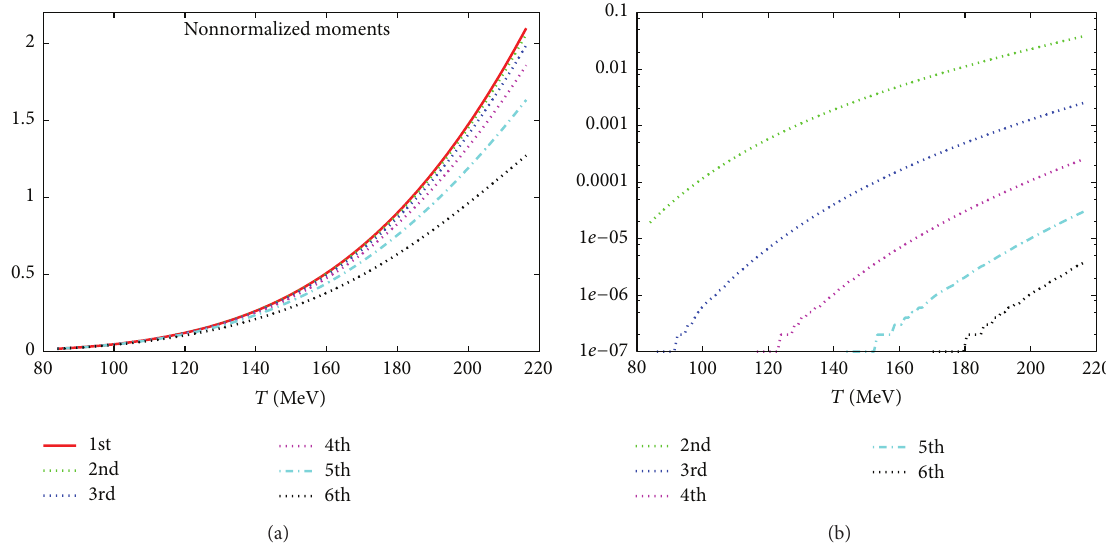
Figure 1: (a) Depicts dimensionless nonnormalized moments depending on the temperature. (b) Shows the evolution of the so-called correlation parts (the integrals appearing in (17)) with the temperature. (b) Shows the new coefficients that resulted in when going from lower to higher order moments of multiplicities in a log